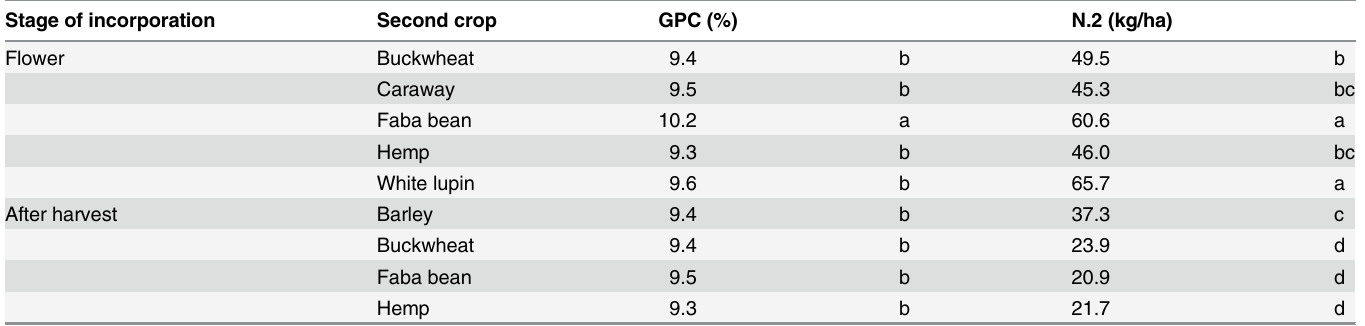
Table 4. Grain protein content of barley and soil nitrogen content two months after incorporating the second crop, according to the second crop and its stage of incorporation. Stage of incorporation Second crop GPC (%) N.2 (kg/ha) Flower Buckwheat 9.4 b 49.5 b Caraway 9.5 b 45.3 bc Faba bean 10.2 a 60.6 a Hemp 9.3 b 46.0 bc White lupin 9.6 b 65.7 a After harvest Barley 9.4 b 37.3 c Buckwheat 9.4 b 23.9 d Faba bean 9.5 b 20.9 d Hemp 9.3 b 21.7 d Data show means across fi rst crops and